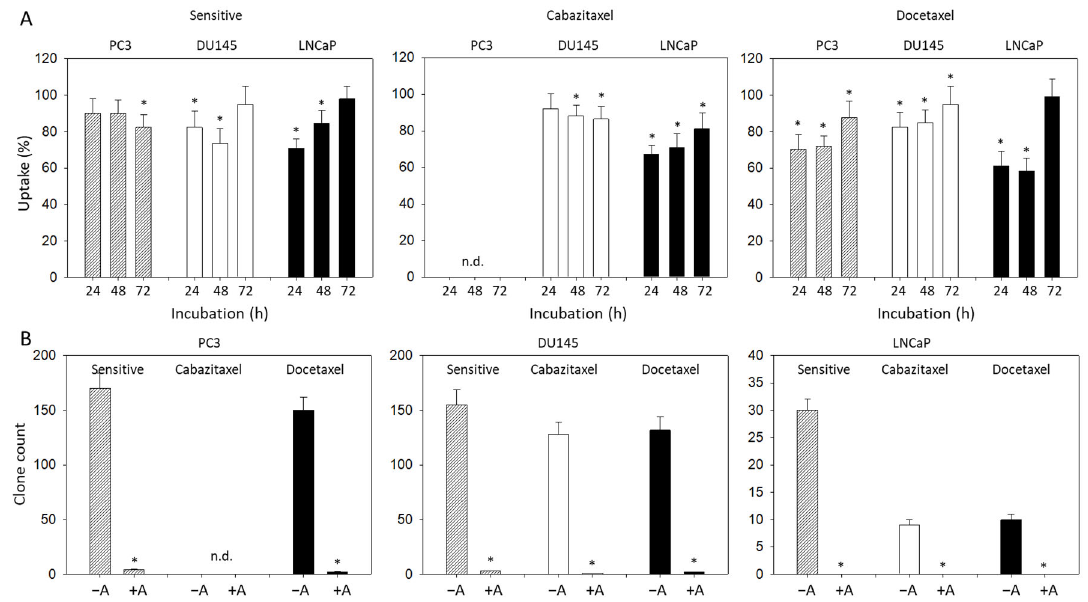
Figure 3. ( A ): BrdU uptake in sensitive and drug-resistant PC3, DU145, and LNCaP cells following amygdalin exposure for 24, 48, and 72 h. Values are given in percentage and are related to untreated controls, which were set to 100%. ( B ): Number of PC3, DU145, and LNCaP clones (drug-sensitive, cisplatin-resistant, and gemcitabine-resistant) exposed to amygdalin (+A), compared to the nontreated controls ( − A). Error bars indicate standard deviation (SD), n = 3. * indicates significant difference to untreated controls. n.d.: not done.